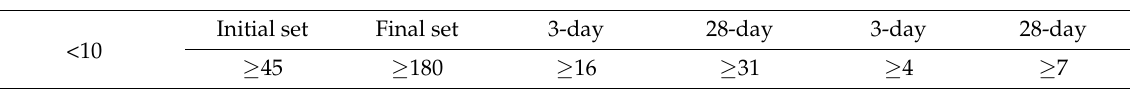
Table 2. Technical parameters of cement.